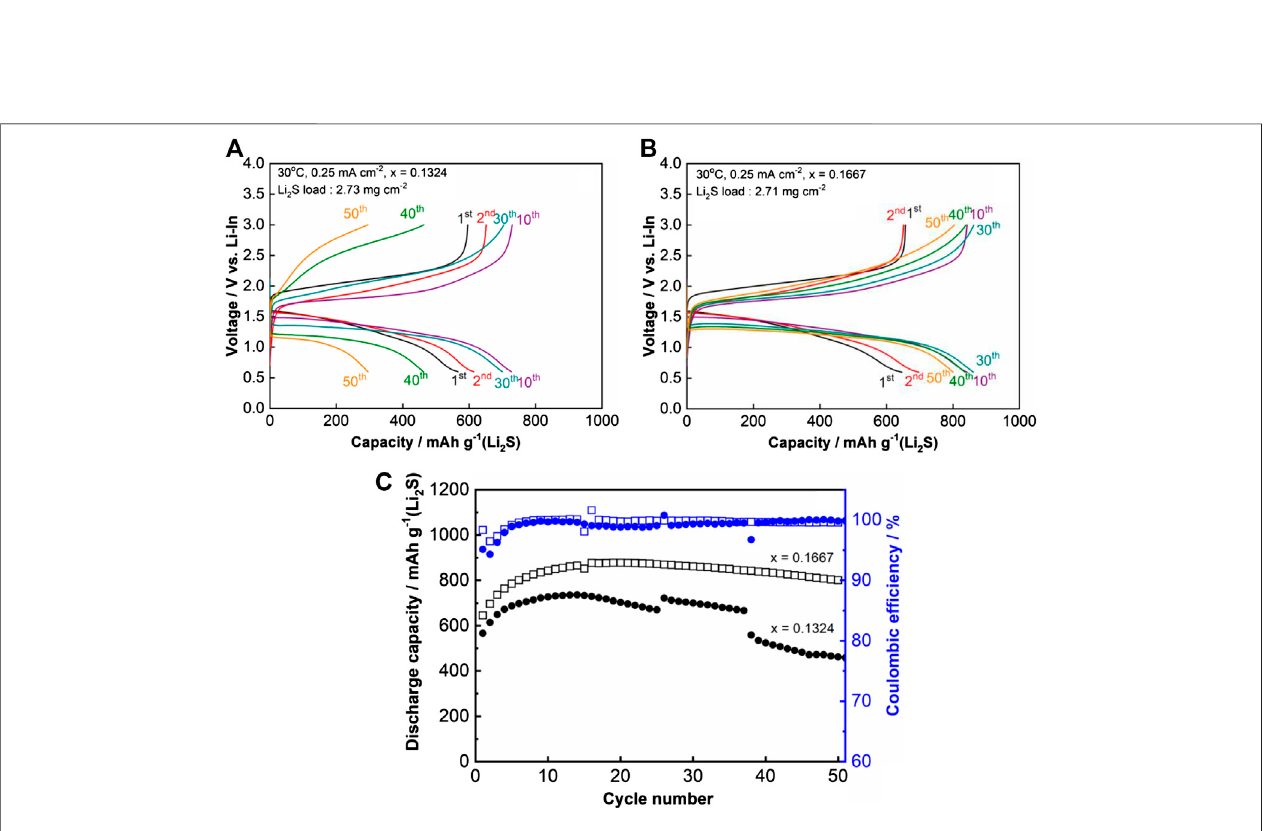
FIGURE 4 | Charge-discharge curves and cycling performance of the prepared all-solid-state cell. (A) charge-discharge curves of x (cid:1) 0.1324; (B) x (cid:1) 0.1667; and (C) cycling performance of x (cid:1) 0.1324 and 0.1667 over 50 cycles at 30 ° C.